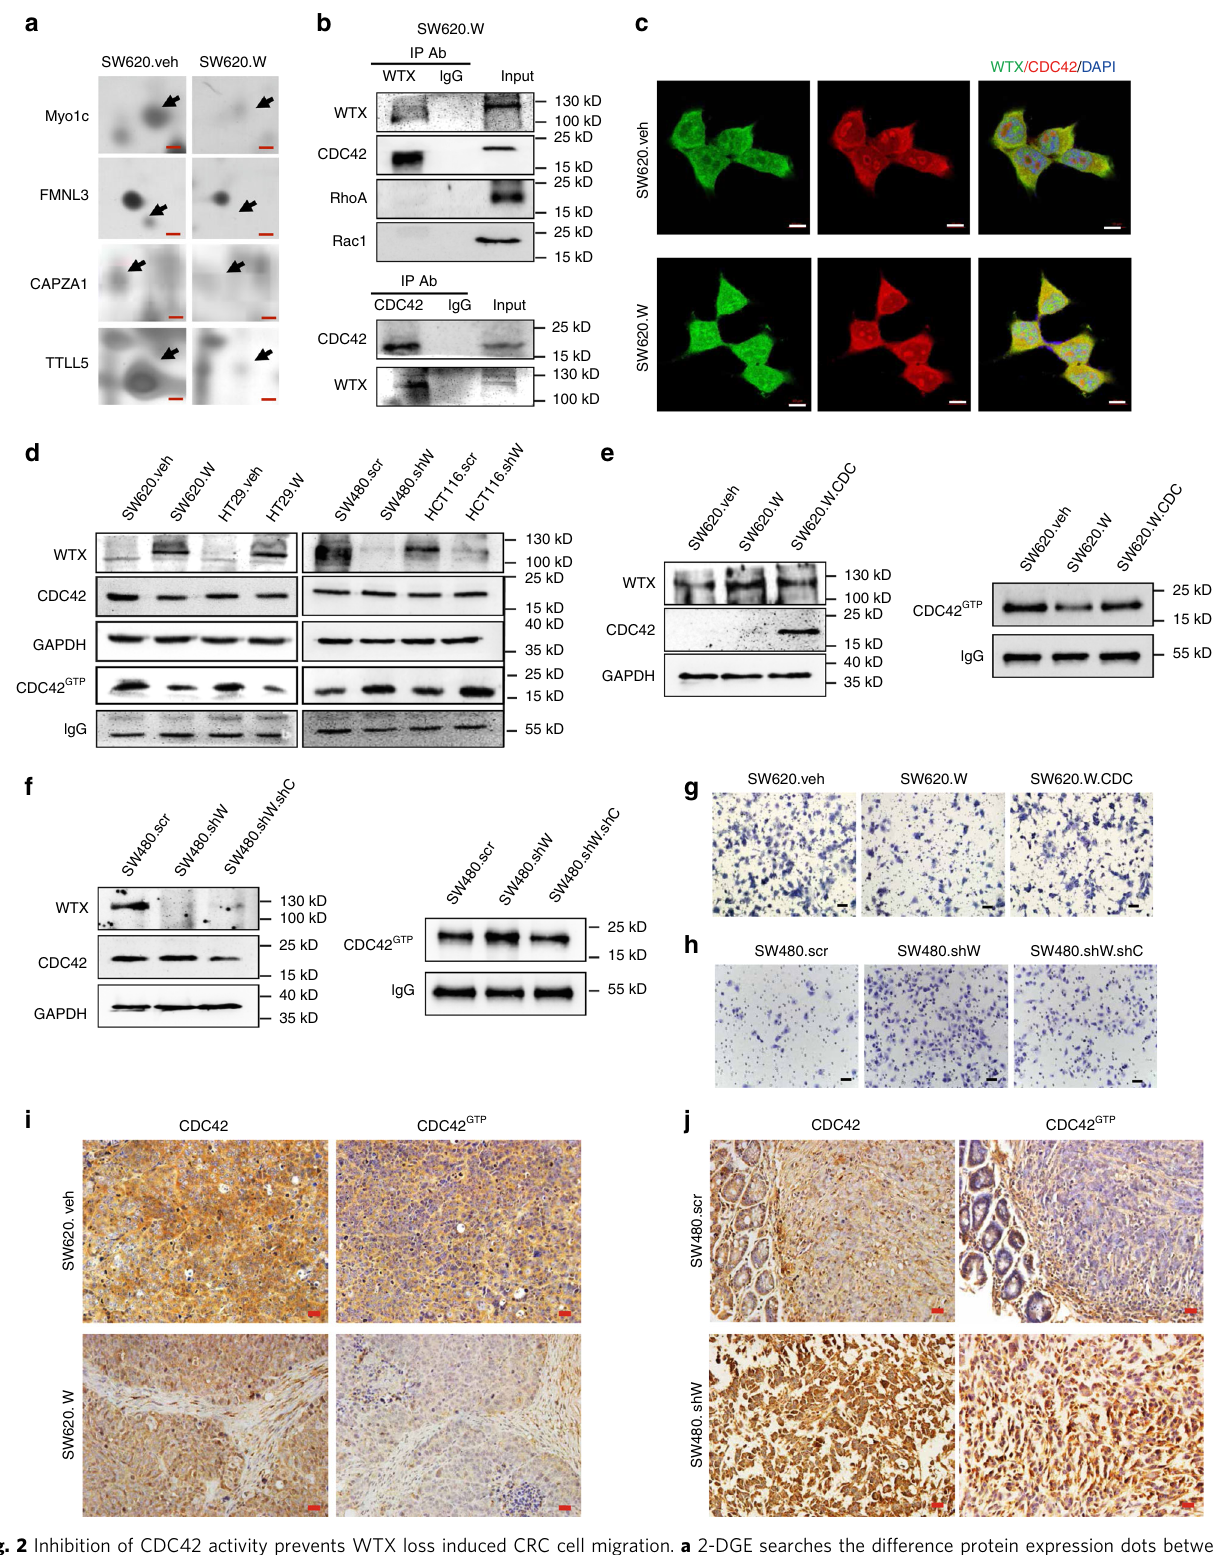
Fig. 2 Inhibition of CDC42 activity prevents WTX loss induced CRC cell migration. a 2-DGE searches the difference protein expression dots between SW620.veh and SW620.W cells. Scale bars, 500 μ m. b CO-IP analyzes the interaction of WTX and Small GTPases family members in SW620.W cells. c IF staining analyzes the colocation of WTX and CDC42 in SW620.veh and SW620.W cells. Scale bars, 10 μ m. d IB analyzes the expression level of CDC42 and CDC42 GTP in indicated cell lines. e , f IB analyzes the expressions of WTX, CDC42 and CDC42 GTP in indicated cells. g , h Transwell experiments analyze the migration ability in indicated cells. Scale bars, 200 μ m. i , j IHC staining analyzes the expressions of CDC42 and CDC42 GTP in CRC orthotopic tumors. Scale bars, 20 μ